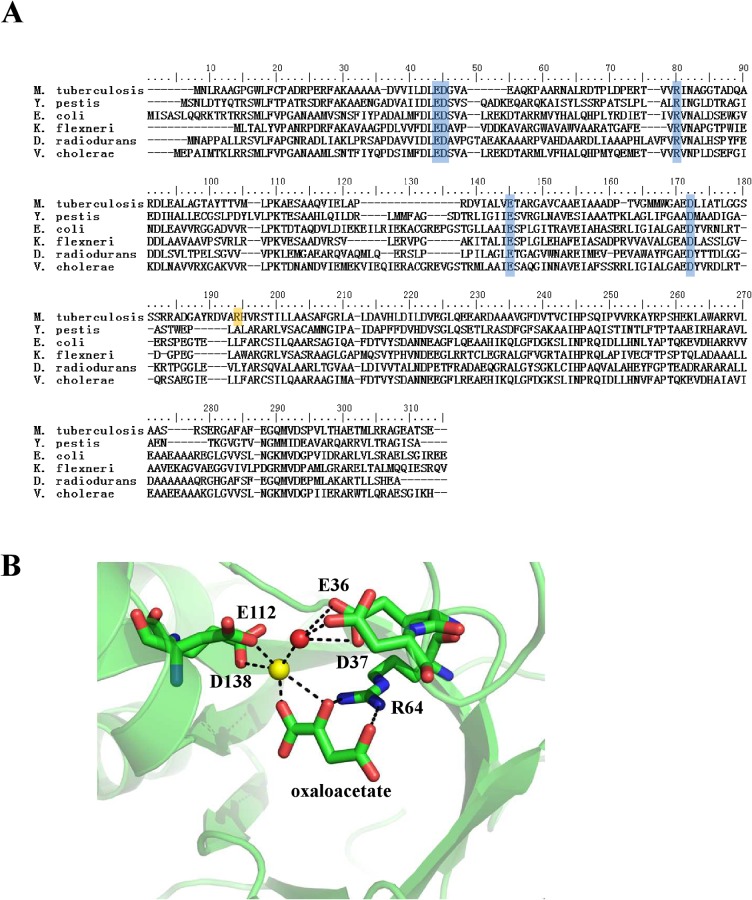
Selection of conservedconversed residues in CitE catalytic site.(A) Multiple sequence alignment between MtbCitE (citrate lyase β-subunit) and citrate lyase β-subunit from Y. pestis, E. coli, K. flexneri, D. radiodurans and V. cholerae. The conserved residues in these species are highlighted in blue; the residue involved in ATP binding is highlighted in orange. The amino acid sequence alignment was analyzed using CLUSTALW. (B) Cartoon diagram of MtbCitE with magnesium ion and oxaloacetate. The illustration was generated with structure 1Z6K deposited in the PDB by PYMOL. Magnesium ion and water molecule are shown as a yellow sphere and a red sphere respectively. The residues involved in binding Mg2+ and oxaloacetate are shown in a stick representation with differently colored atoms. The hydrogen bonds between atoms are shown with broken black lines.